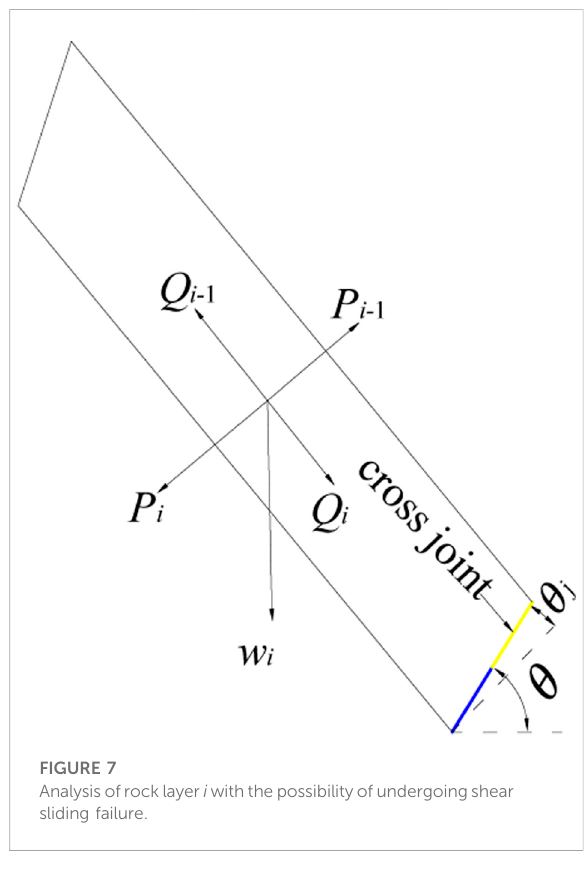
FIGURE 7 Analysisofrocklayer i withthepossibilityofundergoingshear sliding